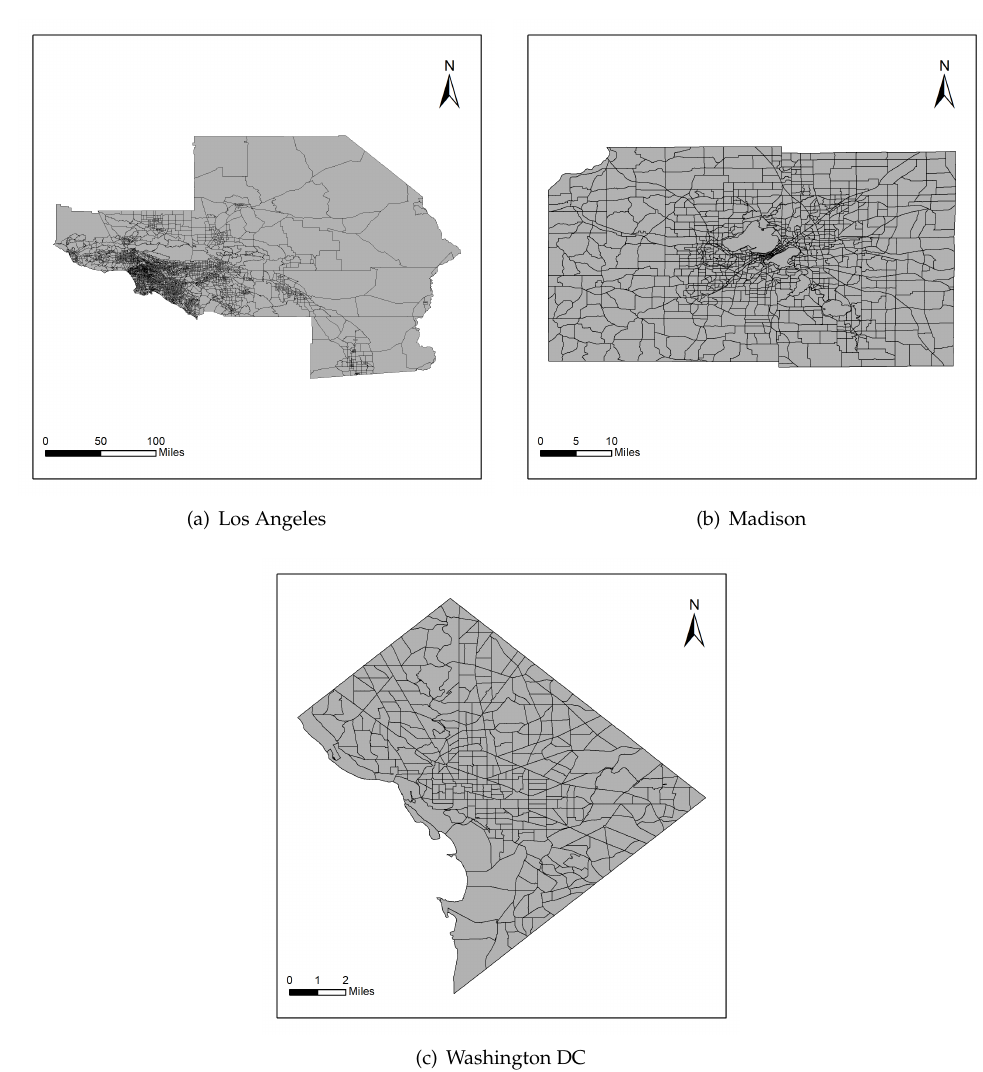
Figure 8: Traffic Analysis Zones (TAZs) of the three cities in this research.